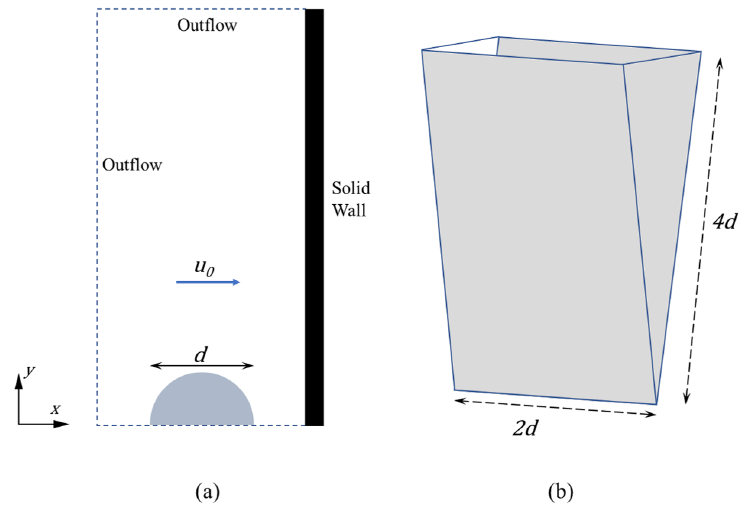
Figure 3. Initial configuration and boundary conditions ( a ) with computational domain ( b